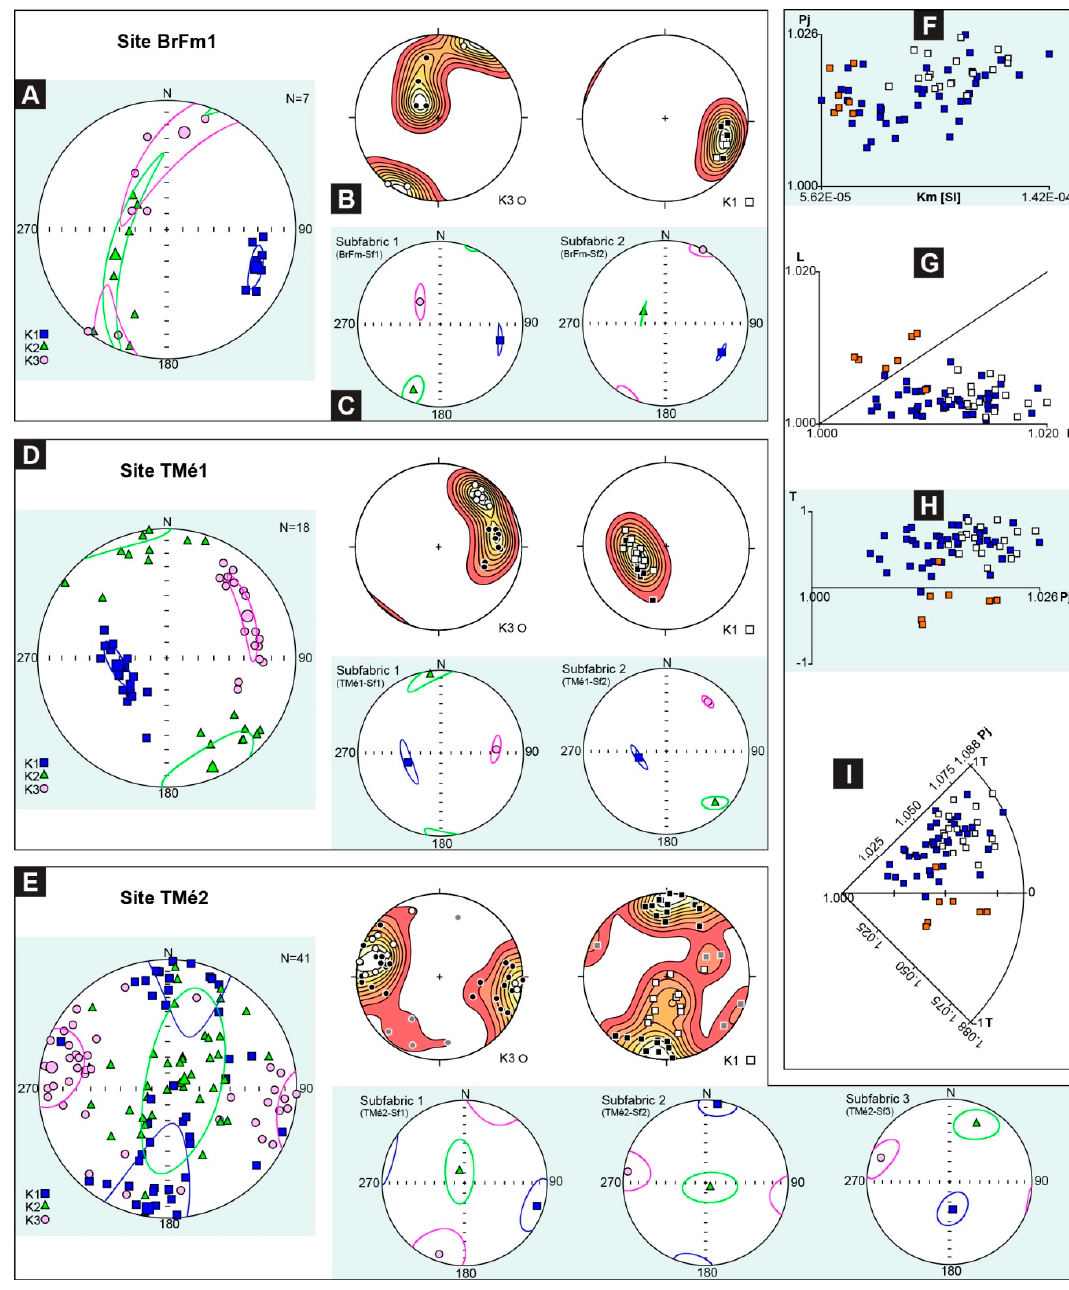
Figure 5. Tectonic fabric of tectonic mélange specimens: ( A ) stereoplots (lower-hemisphere projections) showing the shapes and attitudes of the magnetic susceptibility ellipsoids from the broken formation (site BrFm1); ( B ) density diagrams of k 1 and k 3 axes (contour interval = 10) and ( C ) relative subfabrics; tectonic mélanges, site TMé1 ( D ) and Site TMé2 ( E ), AMS data. Whole diagrams for the measured tectonic fabric in which orange, white, and blue squares are respectively BrFm1, TMé1, and TMé2 data: ( F ) anisotropy degree vs mean susceptibility; ( G ) magnetic lineation vs. magnetic foliation; ( H ) shape parameter vs. corrected anisotropy degree; ( I ) π / 4 segment polar plot (see [103]), in which Pj represents the radius and T the arc